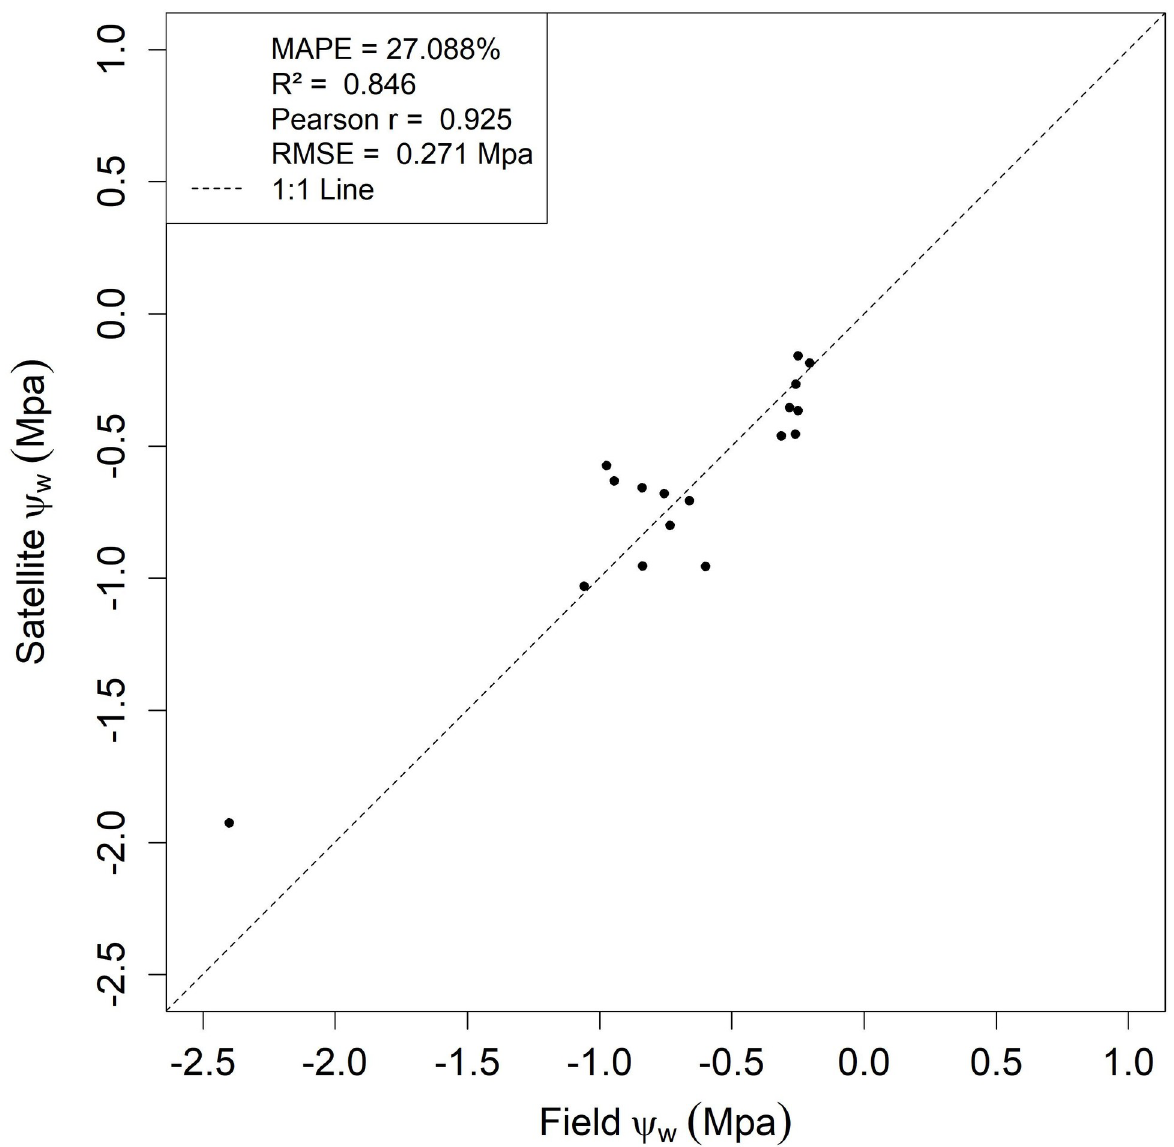
Fig 4. LOOCV results for the NDVI Quad algorithm. The upper left box refers to MAPE, R 2 , Pearson r, and RMSE for the validation using LOOCV.